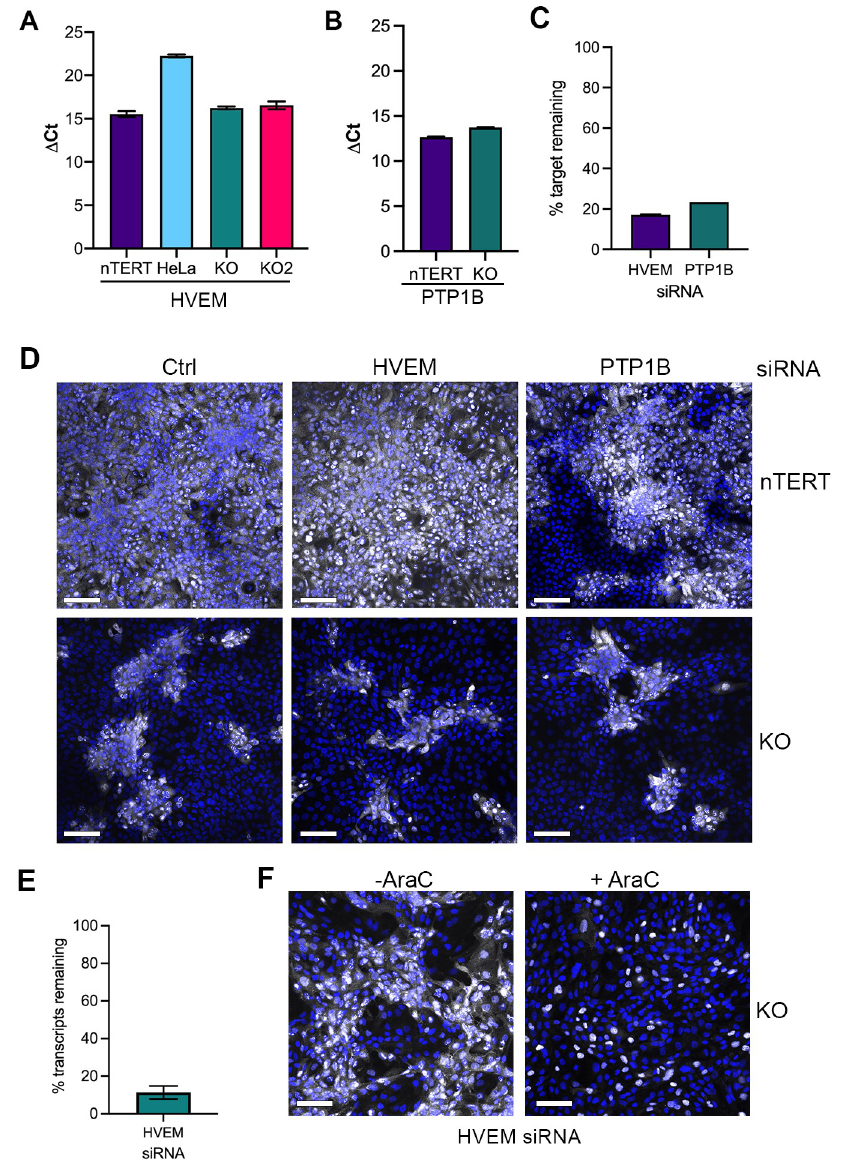
Fig 6. HSV1 spread in the absence of nectin1 does not require HVEM or PTP1B. (A) Total RNA was isolated from HeLa, nTERT, KO and KO2 cells, and subjected to RT-qPCR using primers for HVEM. Results are presented as Δ Ct measurement using 18s as reference (mean ± SEM, n = 3). (B) Total RNA was isolated from nTERT and KO cells and subjected to RT-qPCR using primers for PTP1B. Results are presented as Δ Ct measurement using 18s as reference (mean ± SEM, n = 3). (C) KO cells were transfected with control, HVEM or PTP1B siRNA, and total RNA harvested after 48 h and RT-qPCR performed. Level of mRNA in siRNA transfected cells is presented as the percentage of mRNA in control siRNA transfected cells. (D) nTERT and nectin1 KO cells transfected at the same time as in (C) were infected after 48 h with HSV1 Sc16 MOI 0.1 or 5 respectively, fixed at 16 h and stained for ICP4 (white). Nuclei were stained with DAPI (blue). (E) and (F) KO cells were transfected with HVEM siRNA and after 48 h were (E) subjected to RT-qPCR, or (F) infected with HSV1 Sc16 MOI 5 in the presence or absence of 100 ng/ml AraC for the course of the experiment, and fixed and stained for ICP4 (white) at 16 h. Scale bar = 100 μ